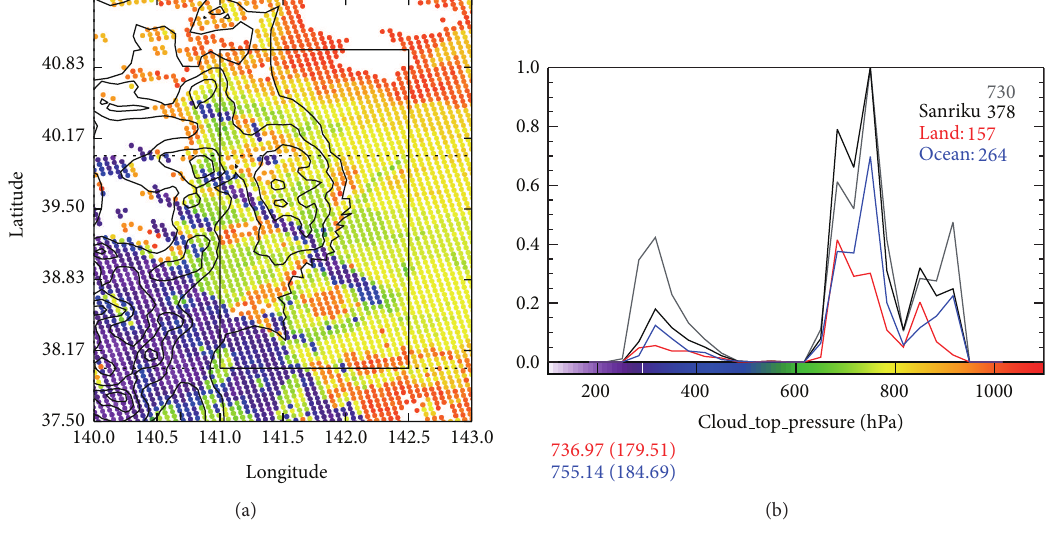
Figure 7: Same as Figure 3 but at 0335 UTC August 16,